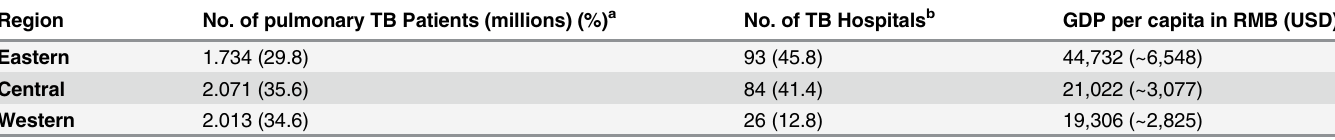
Table 1. Comparison of TB Epidemics, TB specialized hospitals, and GDP per capita among different regions of China. Region No. of pulmonary TB Patients (millions) (%)